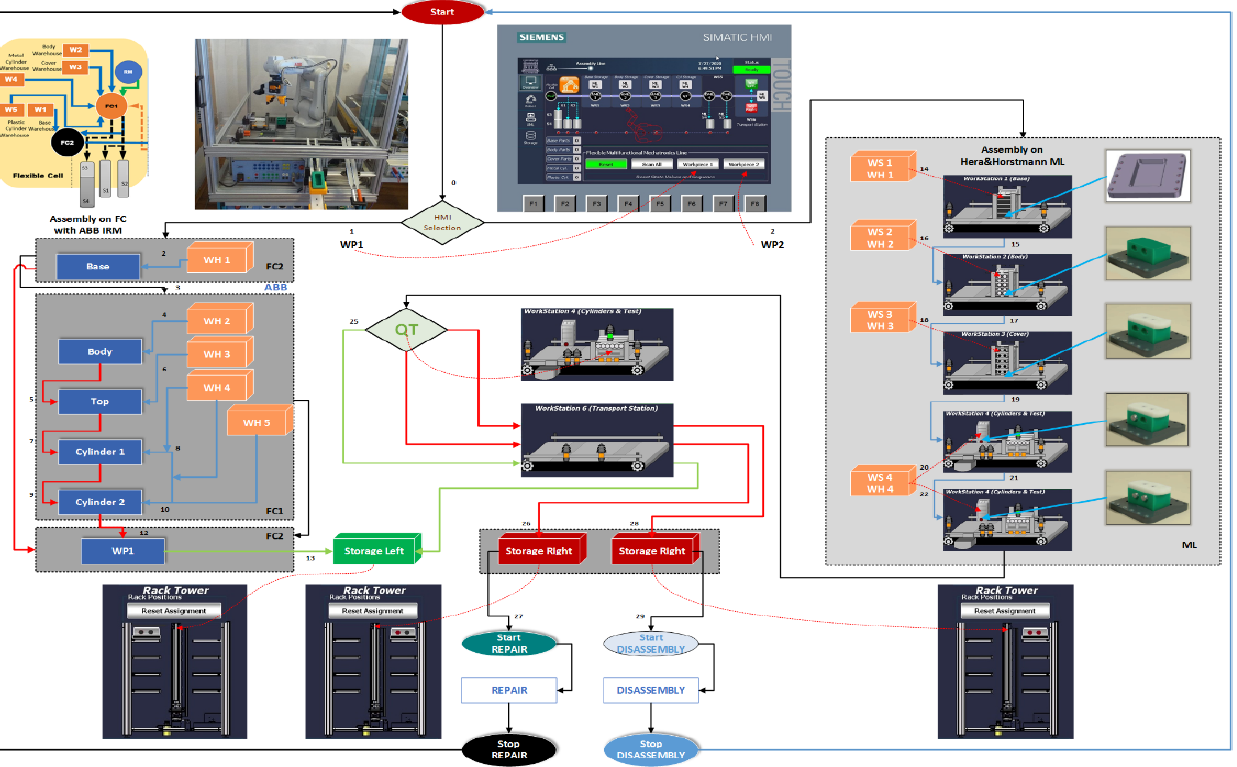
Figure 9. Assembly task planning.